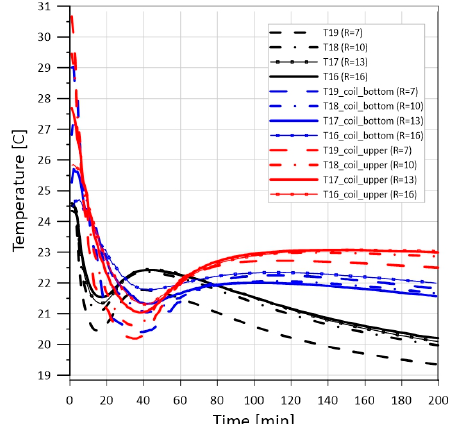
Figure 8. Temperature profile evolution as a function of the radial position during the solidification process with constant wall temperature condition ( Ts = 17 ◦ C) on surface S3 ( a ) and S4 ( b ).